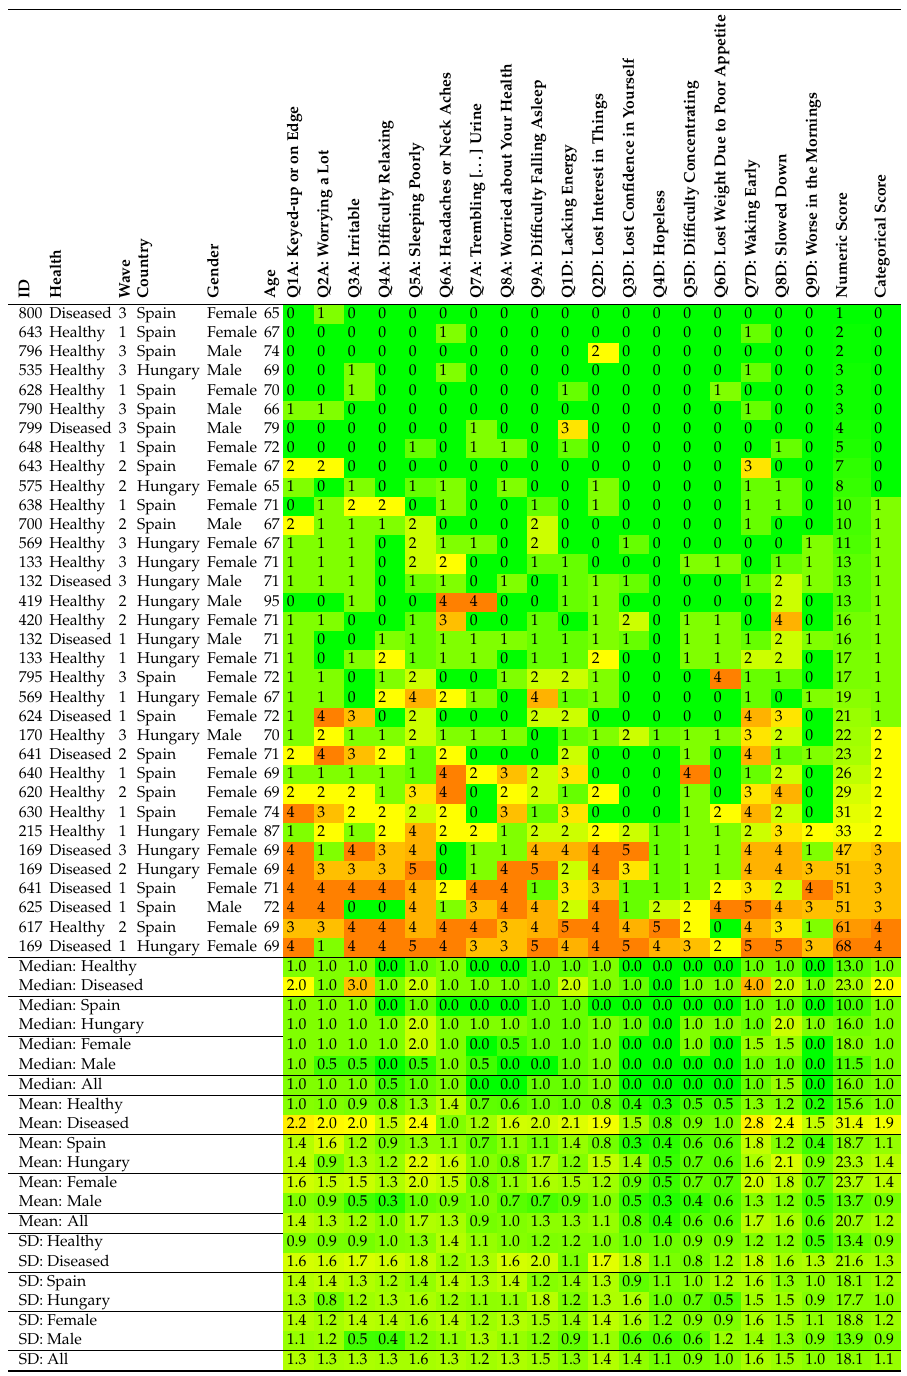
Table A5. Characteristics of PRO Anxiety and Depression